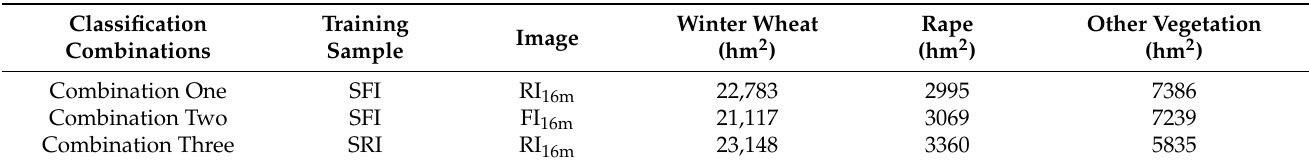
Table 5. Vegetation area information extracted from different classification combinations of training samples and